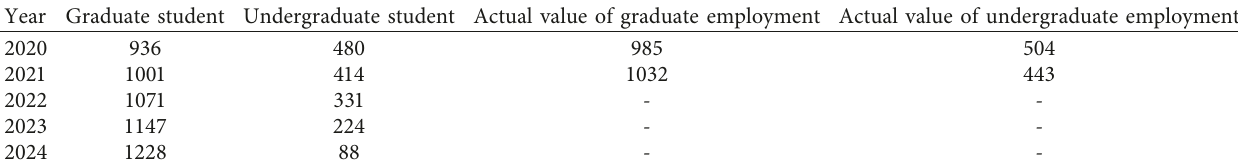
Table 7: The forecasting employment data from Nanjing University of Aeronautics and Astronautics in the aerospace and other defense- related industry.